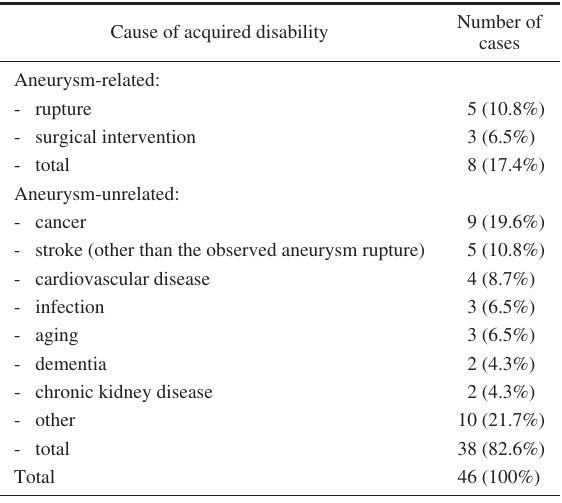
Table 2. Causes of ADL decline during follow-up of patients with unruptured intracranial